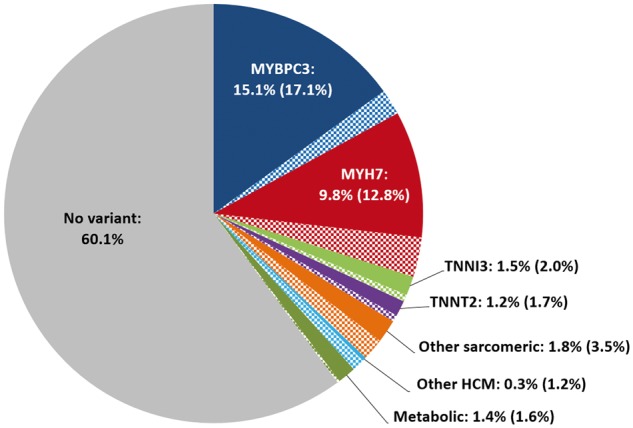
Proportion of HCM patients referred for clinical genetic testing (at OMGL and LMM) with Pathogenic or Likely Pathogenic variants. The percentage in parentheses refer to the total case excess over the frequency of rare variation in ExAC that is expected to reflect the actual yield for each gene (including variants classified as unknown significance shown in the check-patterned slices). The proportions were calculated according to the number of patients sequenced for each gene (up to 6179) and averaged for the three categories - other sarcomeric (ACTC1, MYL2, MYL3, TPM1), other HCM (CSRP3, FHL1, PLN) and metabolic cardiomyopathies (GLA, LAMP2, PRKAG2). Non-essential splice site variants are not included. Over 99% of pathogenic HCM variants occur in the eight core sarcomeric genes (MYH7, MYBPC3, TNNT2, TPM1, MYL2, MYL3, TNNI3, and ACTC1). HCM, Hypertrophic cardiomyopathy.